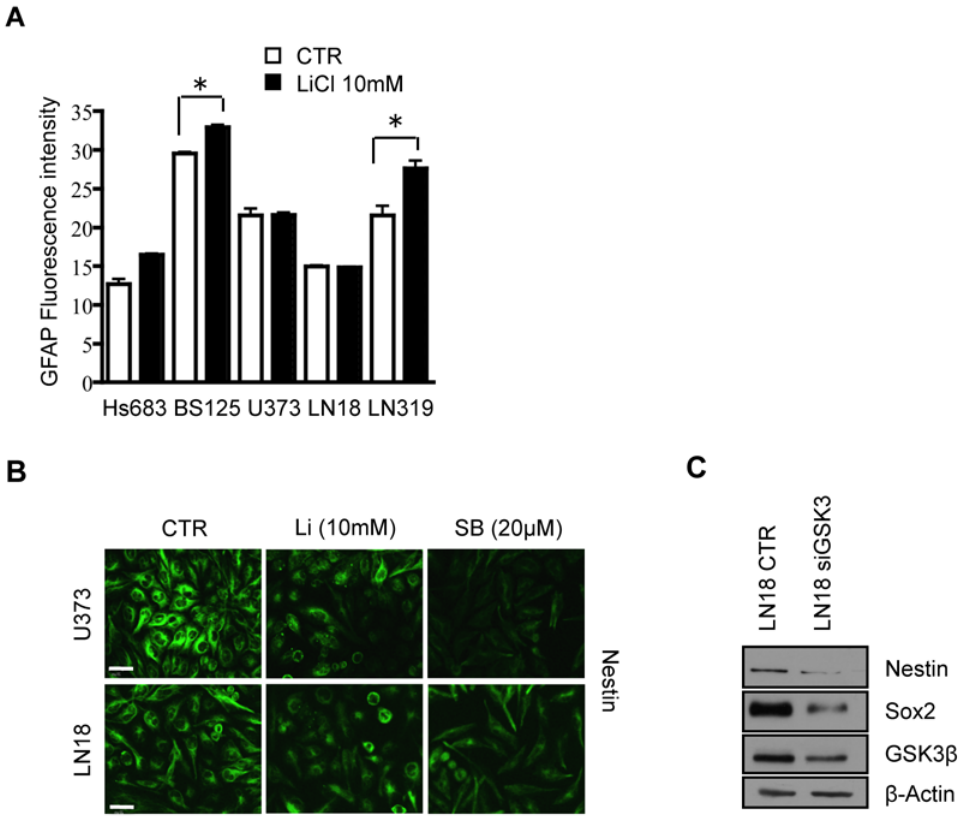
Figure 4. GSK3 b downregulation by siRNA treatment induced differentiation. (A) The intensity of GFAP, an astrocyte-specific marker, was measured by FACS analysis of GBM cell lines treated with 10 mM LiCl for 72 h. (B) Nestin immunostaining of cell lines U373 and LN18 after GSK3 b inhibition by LiCl (Li) or SB216763 (SB) for 72 h. (C) GSK3 b siRNA reduced Sox2 and Nestin expression in the LN18 cell line. * P , 0.05; one-way ANOVA (Newman-Keuls Multiple Comparison Test). Scale bar in B is 30 m m.